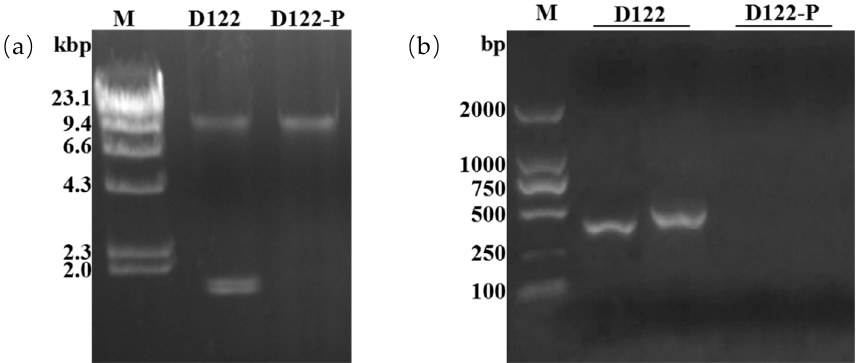
Figure 5. Detection of RsRV5 in strains D122 and D122-P of Rhizoctonai solani AG-1 IA. ( a ) Detection of dsRNA of RsRV5 from a derived strain obtained from protoplast regeneration method. M, λ DNA Hind III markers, D122 is the original mycovirus-infected strain, D122-P is the derived strain obtained from protoplast regeneration method; gDNA: genomic DNA of the fungal strain D122. ( b ) RT-PCR detection of RsRV5 from isogenic strains D122 and D122-P.